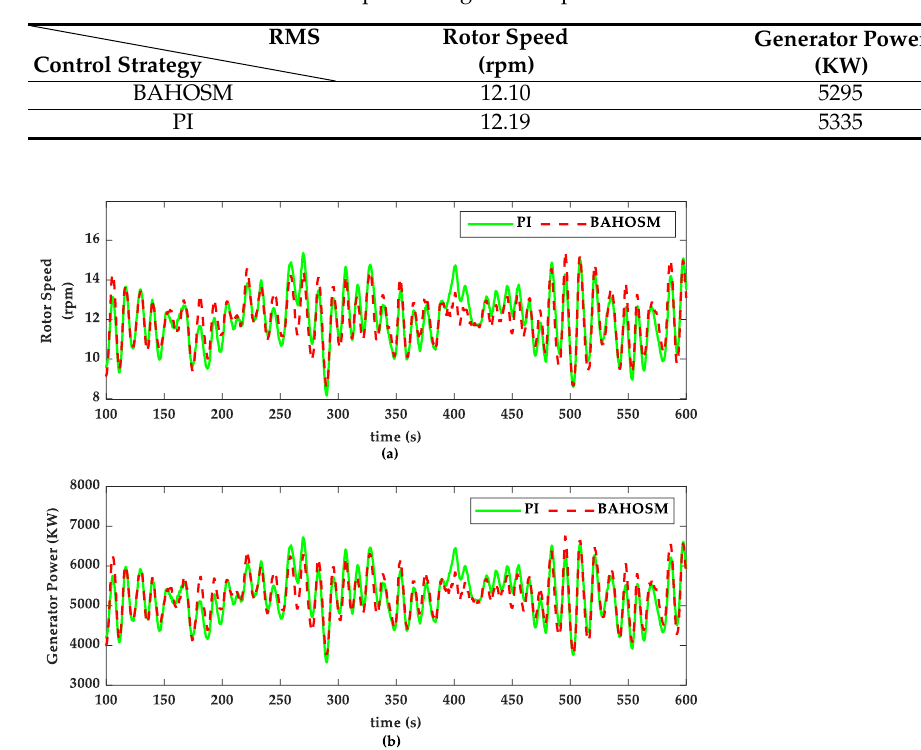
Figure 4. Rotor speed ( a ) and generator power response ( b ) in Case 1. Table 3. RMS values of the rotor speed and generator power for Case 1.